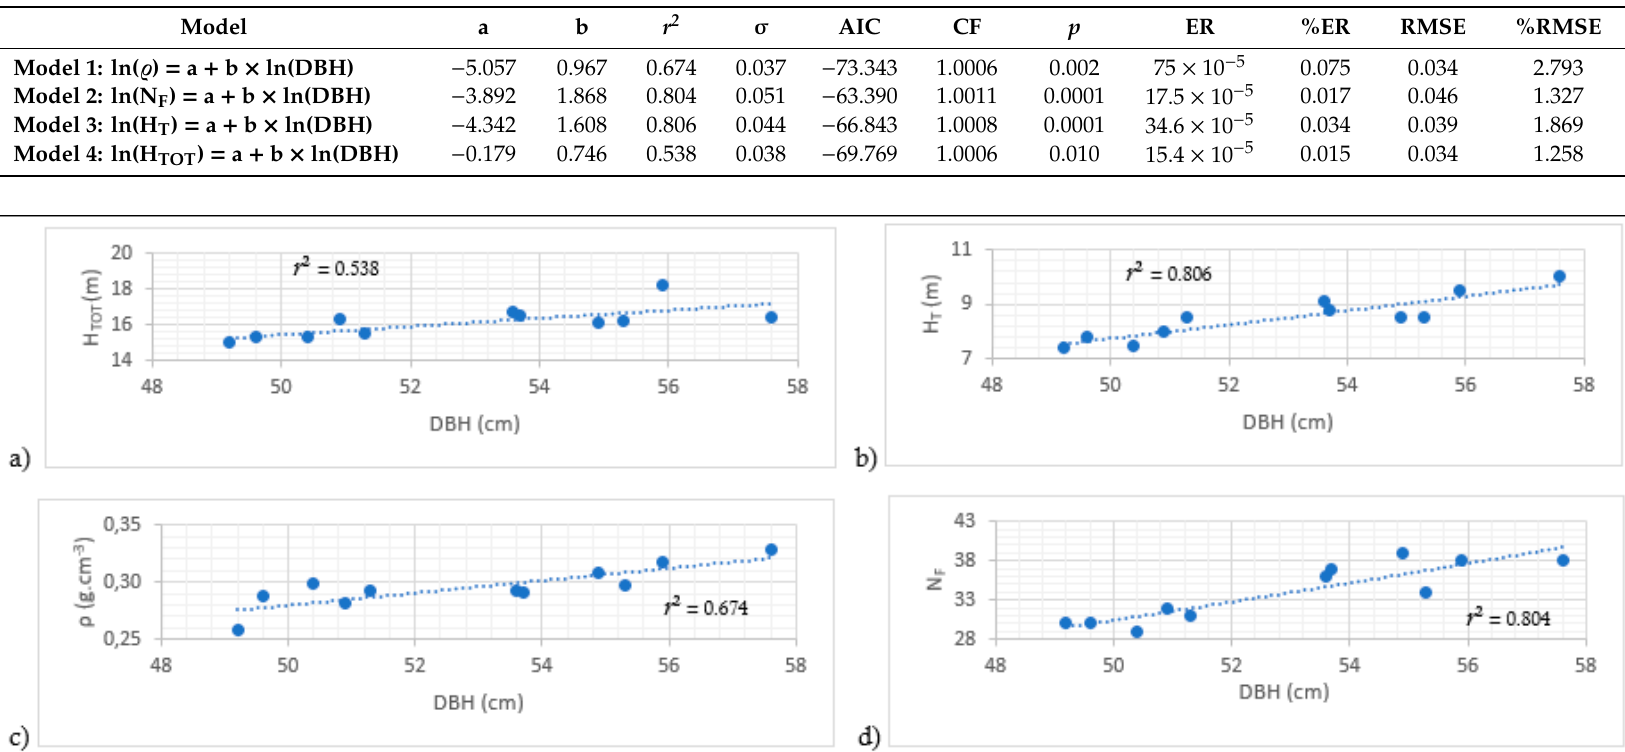
Table 4. Criteria for evaluating the allometric relationships between the DBH and the dependent variables using data from 11 oil palms in Makouké, central Gabon. Values of the coefficients a and b of the models are given; σ is the residual standard error (in kg); p is the p -value of the model. CF is the correction factor for the log-transformed equation. Residual standard errors ( σ , in kg), Akaike Information Criterion (AIC), relative error (ER), relative percentage error (%ER), root-mean-square error (RMSE, in kg) and its percentage (%RMSE) are shown for each equation.